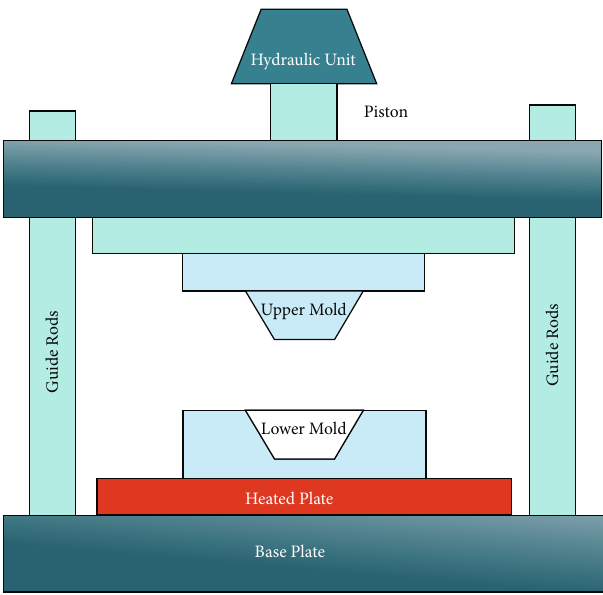
Figure 2: Schematic view of compression molding machine.